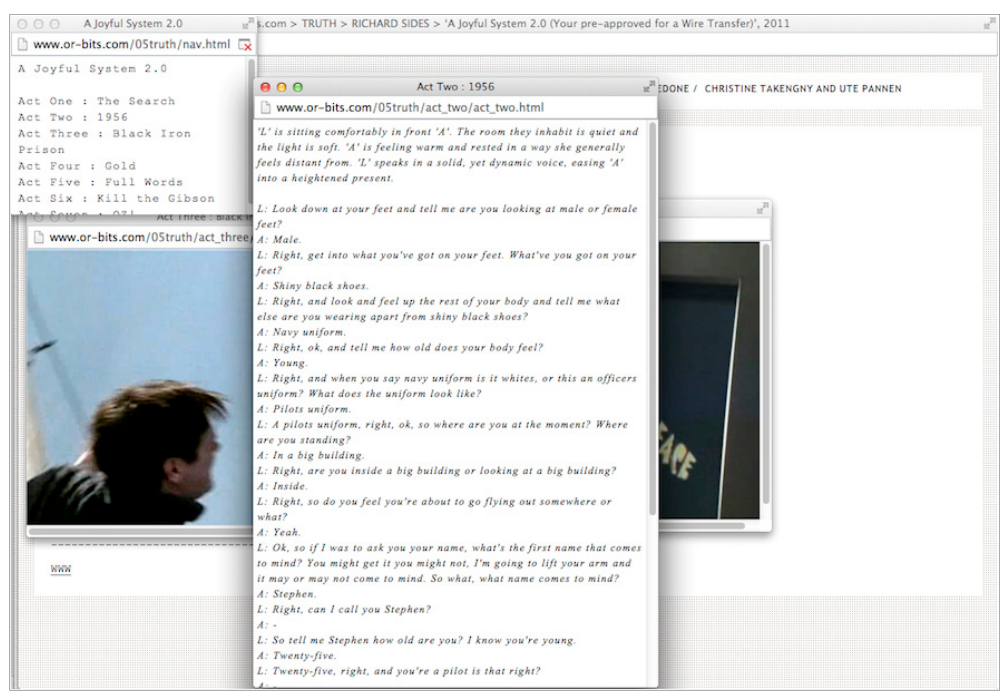
Figure 10. Richard Sides, A Joyful System 2.0 (Your pre-approved for a Wire Transfer) , 2011. In or-bits.com: Truth exhibition, 2011. Screenshot of artwork page. © or-bits.com and the artist, 2019.